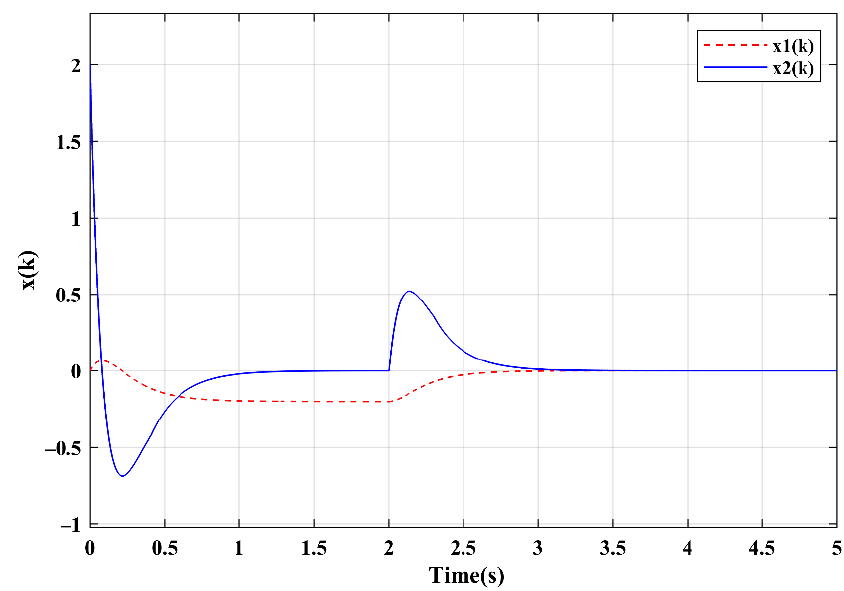
Figure 7. Graph of system state vector changes (SMC and SMPC). Additionally, for the SMPC control strategy simulation, the results are obtained as shown in Figure